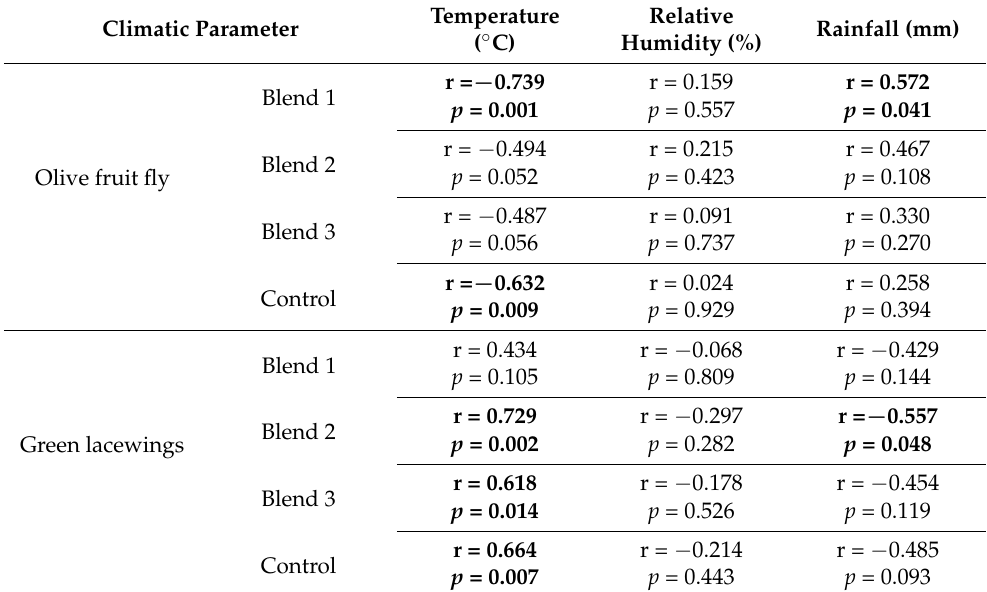
Table 2. The correlation between climatic parameters and the abundance of Bactrocera oleae and green